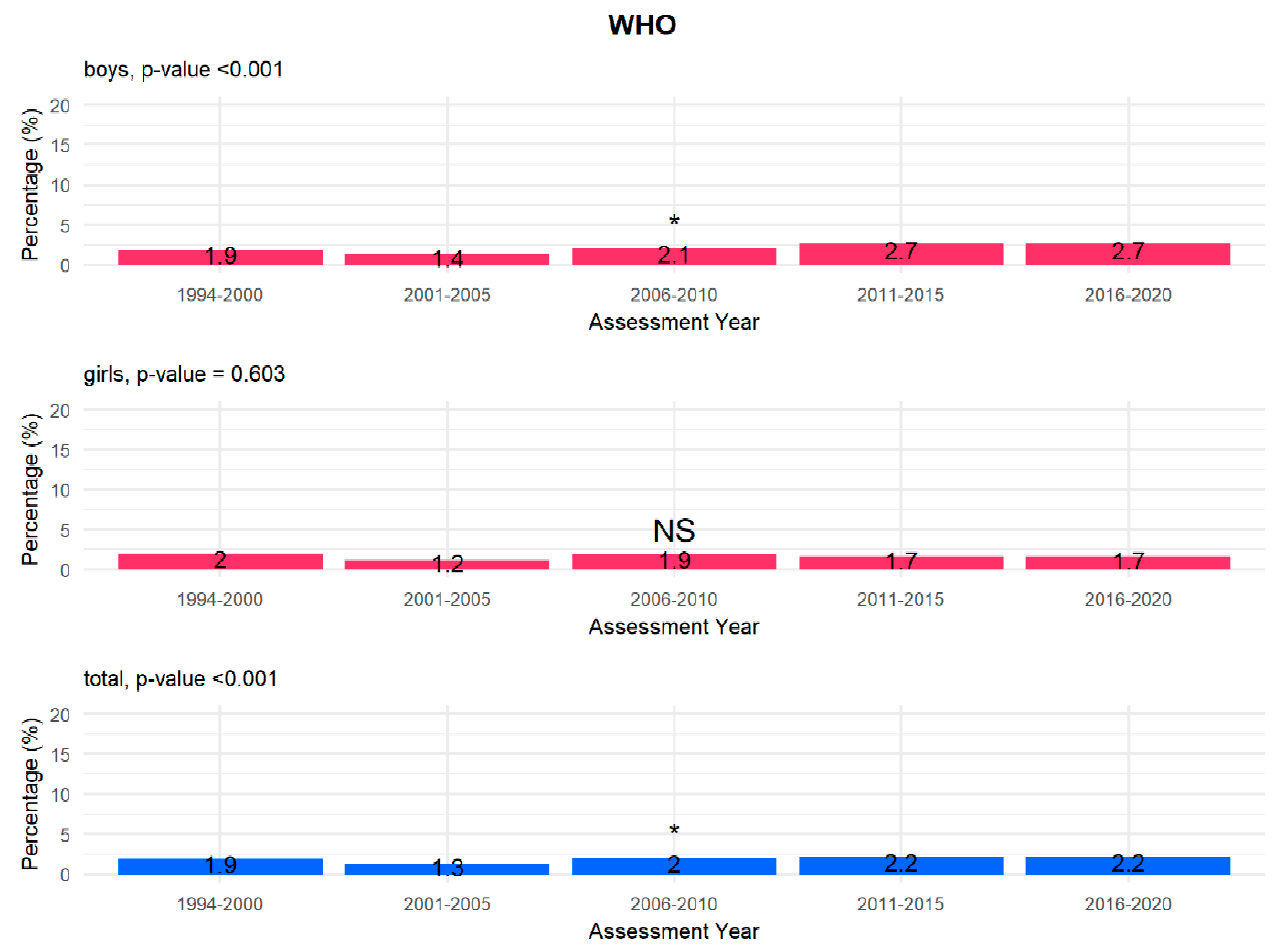
Figure 3. Prevalence of underweight children according to the OLAF criteria by gender and year (total p value < 0.001, boys p value < 0.001, girls p value 0.787). *—significant linear trend, NS—not significant.